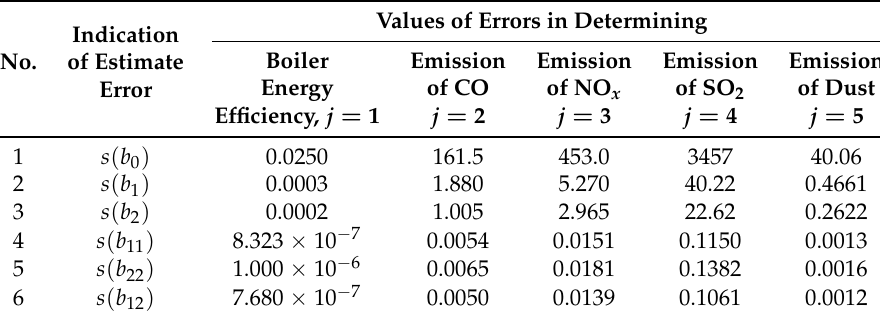
Table 4. Standard errors in estimating the structural parameters of the test object functions.